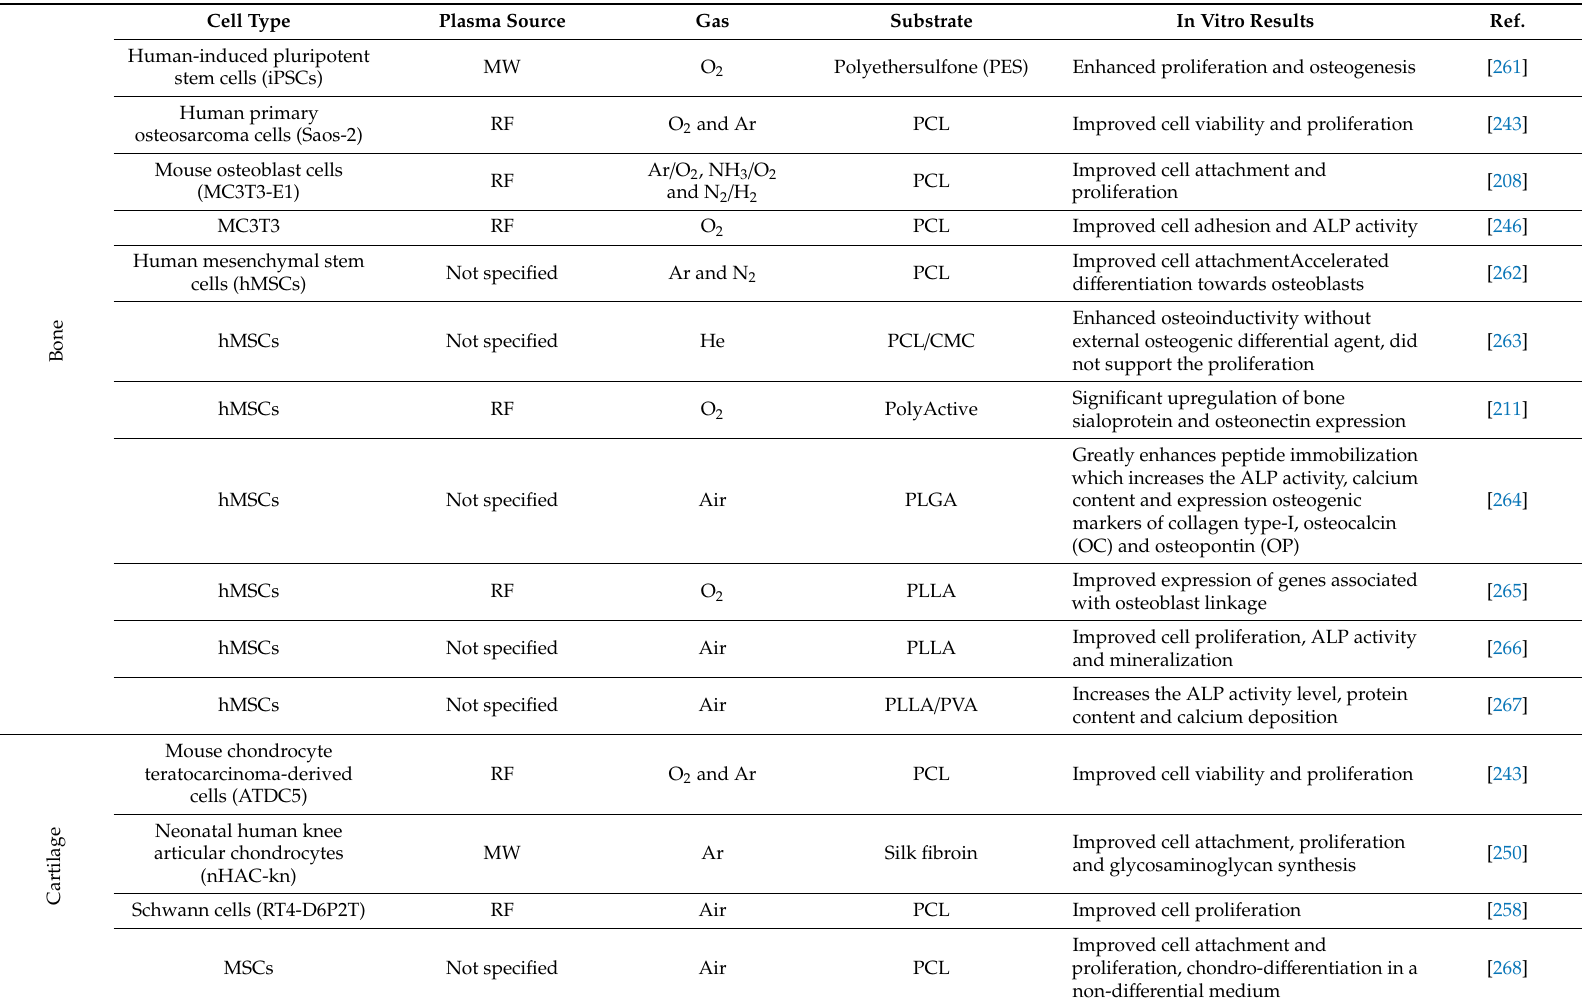
Table 7. Summary of in vitro cell studies performed on plasma-activated nanofibrous sca ff